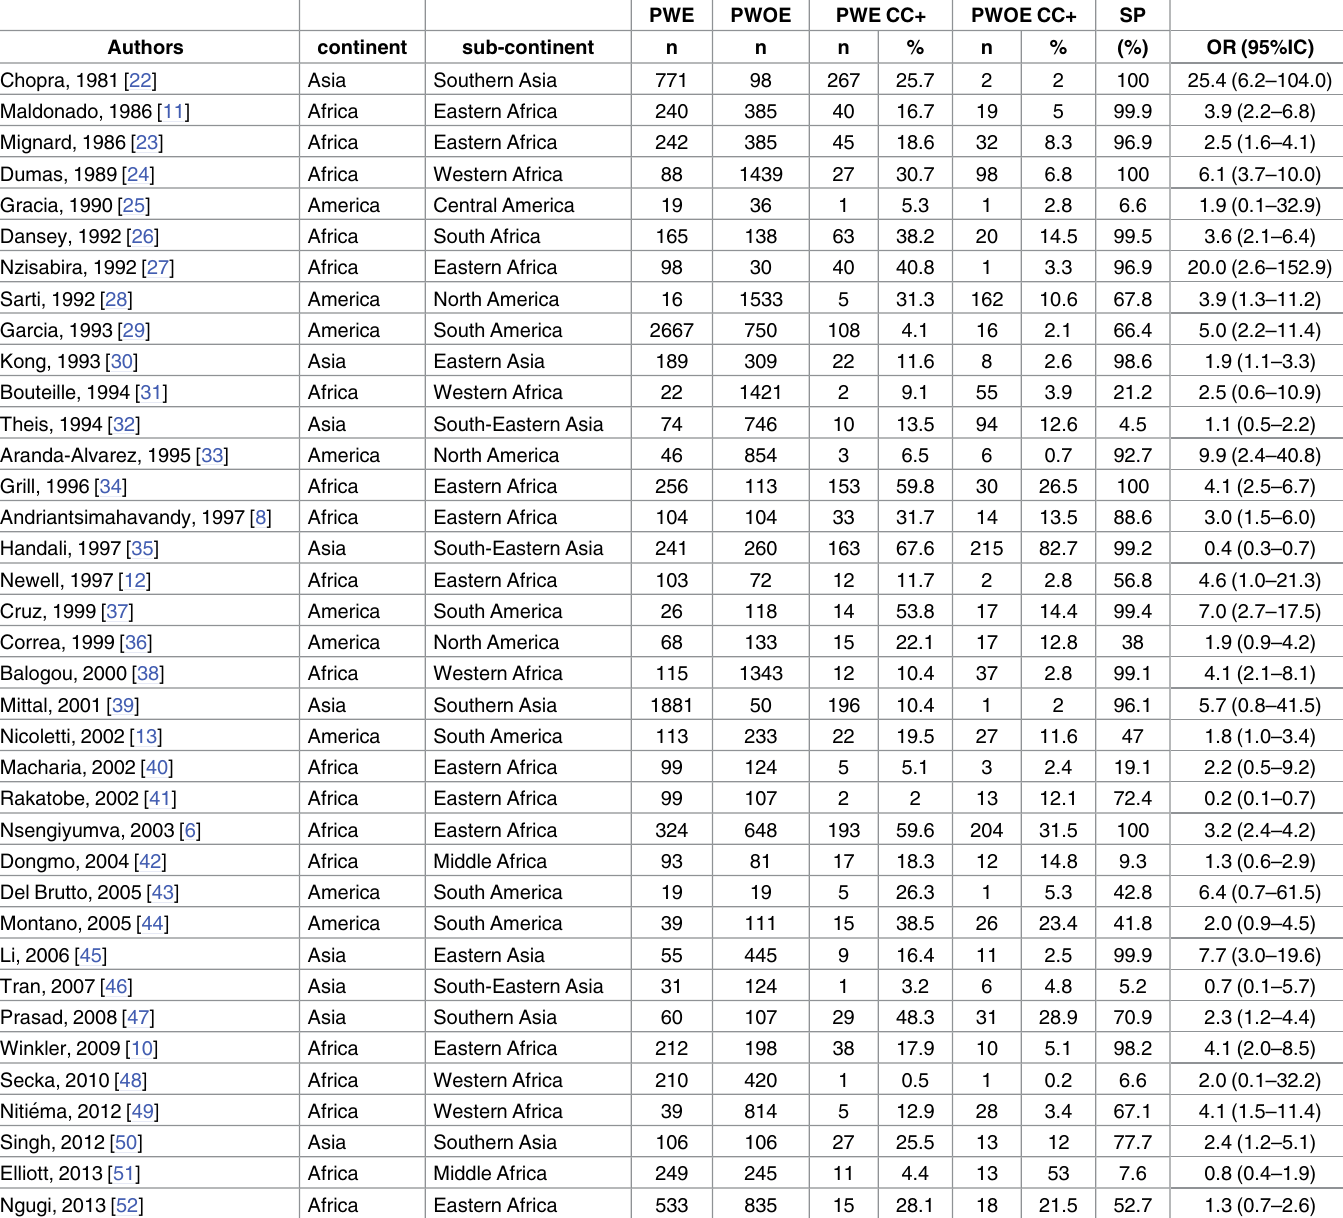
Table 3. Results obtained in studies looking for an association between cysticercosis and epilepsy classified by continent and sub-continent.